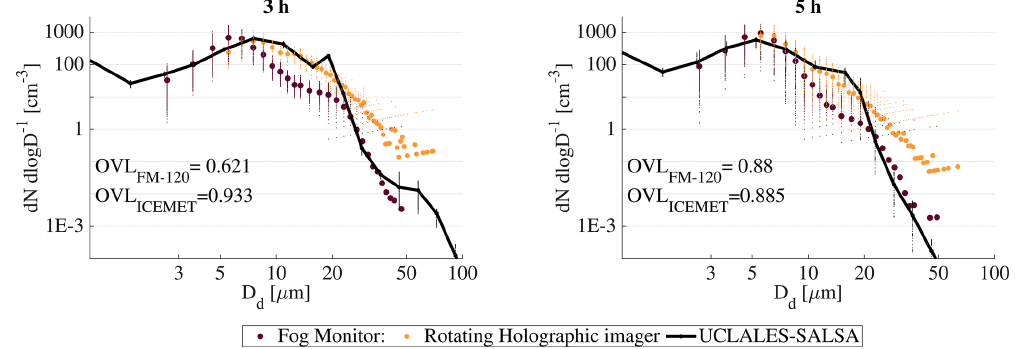
Figure 8. Model outputs of droplet size distributions at Puijo altitude of 225m for case 1, 24 September 2020, compared to observations from the fog monitor (FM-120) and the holographic imaging system (ICEMET). Overlapping index values (OVLs) are included as indicators of agreement between distributions.